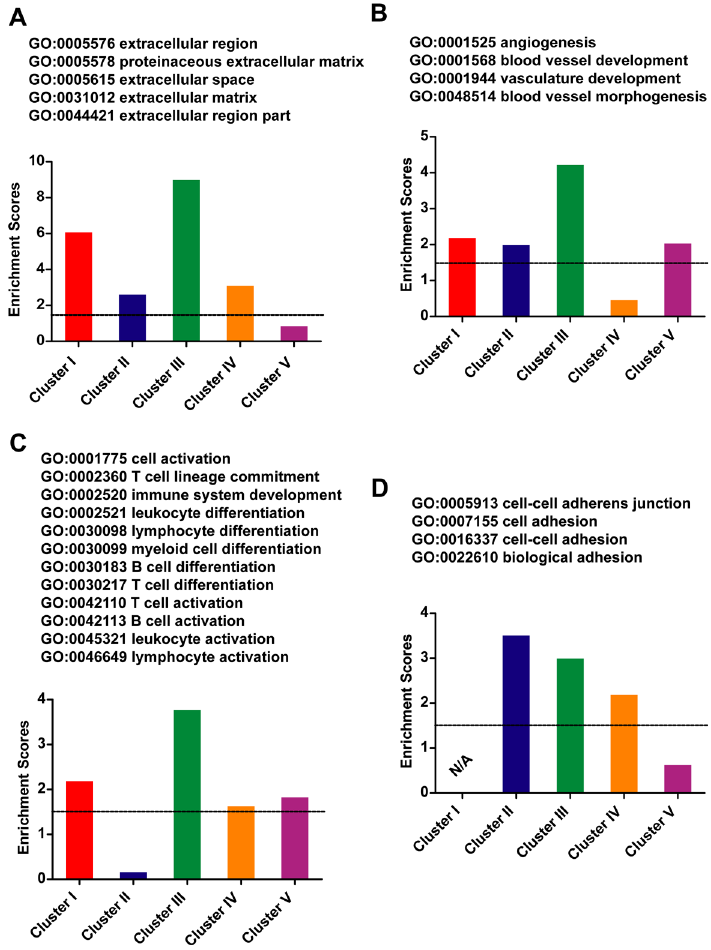
Fig 4. GO terms enriched in at least three clusters. Five clusters of human EMT-induction samples were used to identify five gene lists, which were subjected to GO analysis. The GO terms enriched in at least three clusters were listed. Averaged enrichment scores for related GO terms were represented. (A) extracellular matrix with five GO terms. (B) angiogenesis with four GO terms. (C) T/B cell activation with twelve GO terms. (D) cell adhesion with four GO